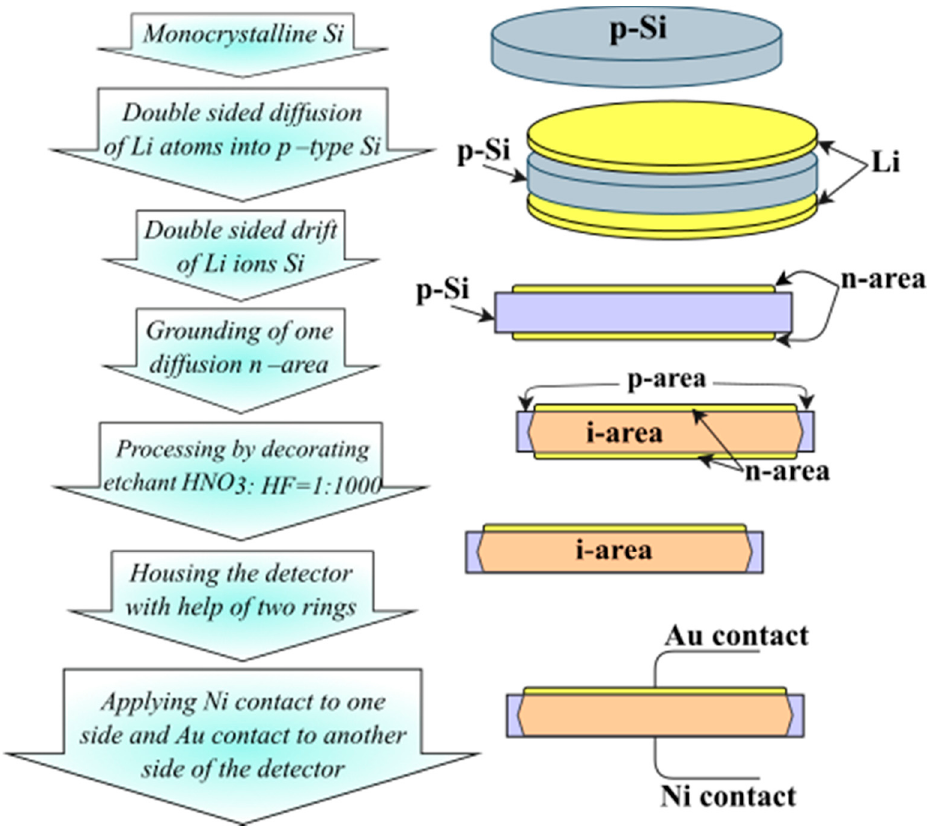
Figure 1. Schematic of manufacturing large-sized detectors, with double-sided diffusion and drift of lithium-ions, into monocrystalline silicon technology .